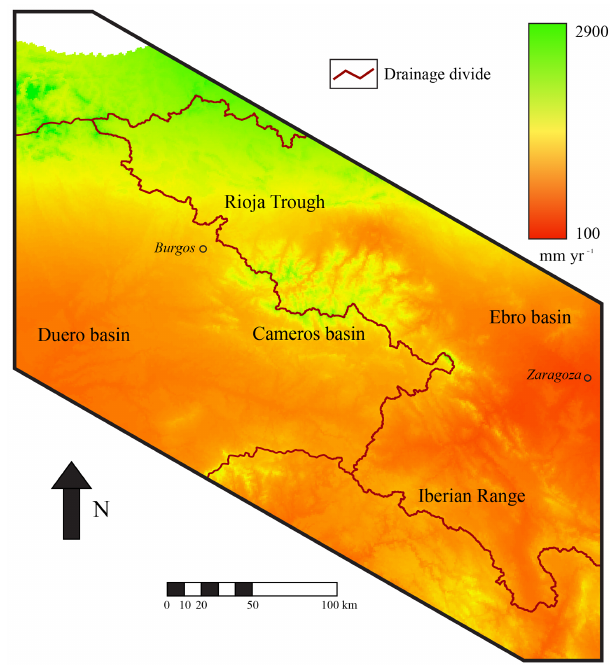
Figure 6. Mean annual precipitation map for the study area (data from Hijmans et al.,